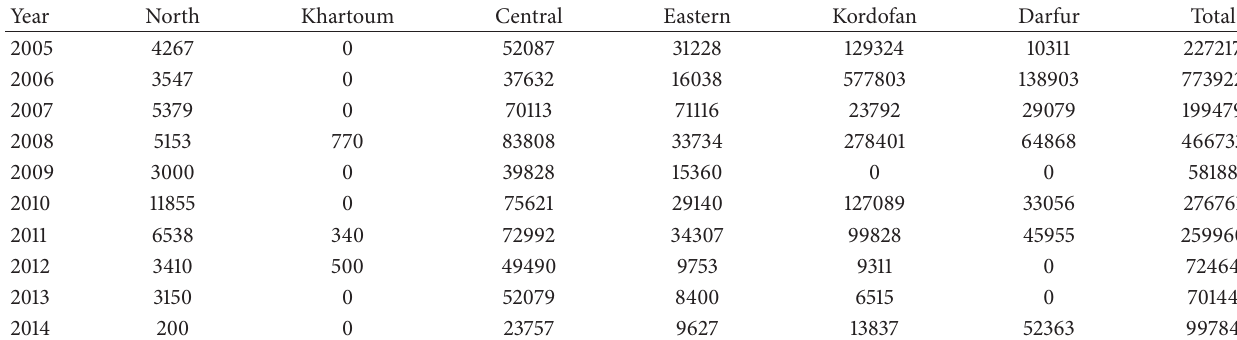
Table 19: Firewood by state in m 3 [8].